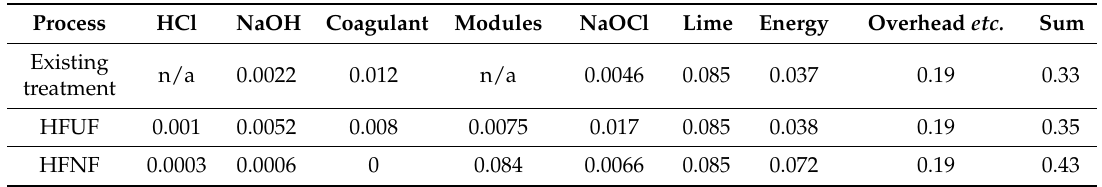
Table 1. Costs for the process parameters in € /m 3 .